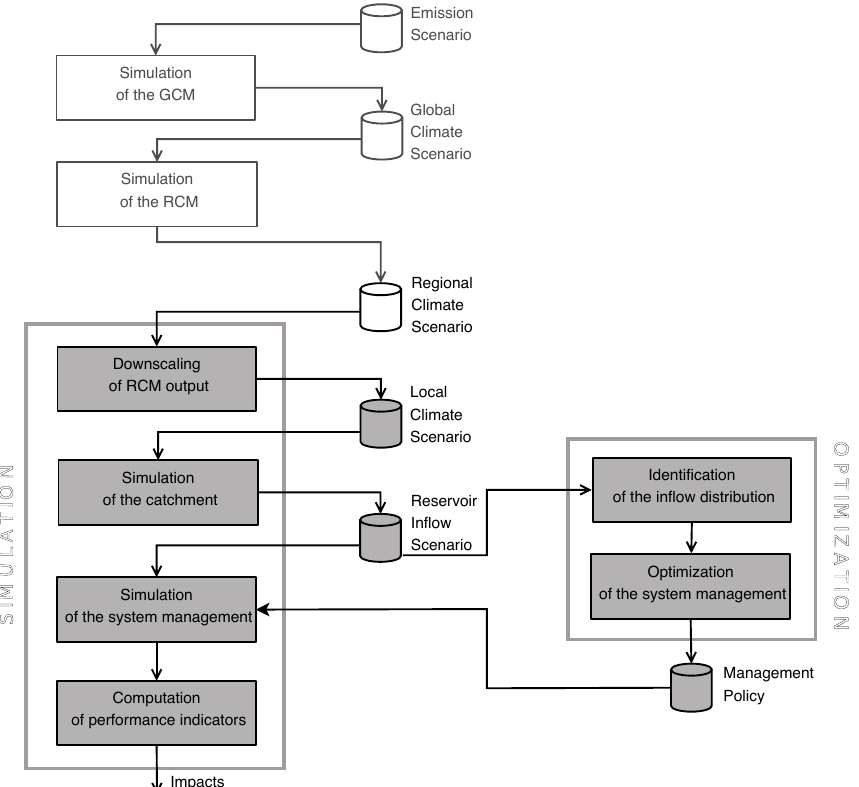
Fig. 2. The procedure for quantitative assessment of climate change impacts on water-related activities: simulation tools on the left side, optimization tools on the right